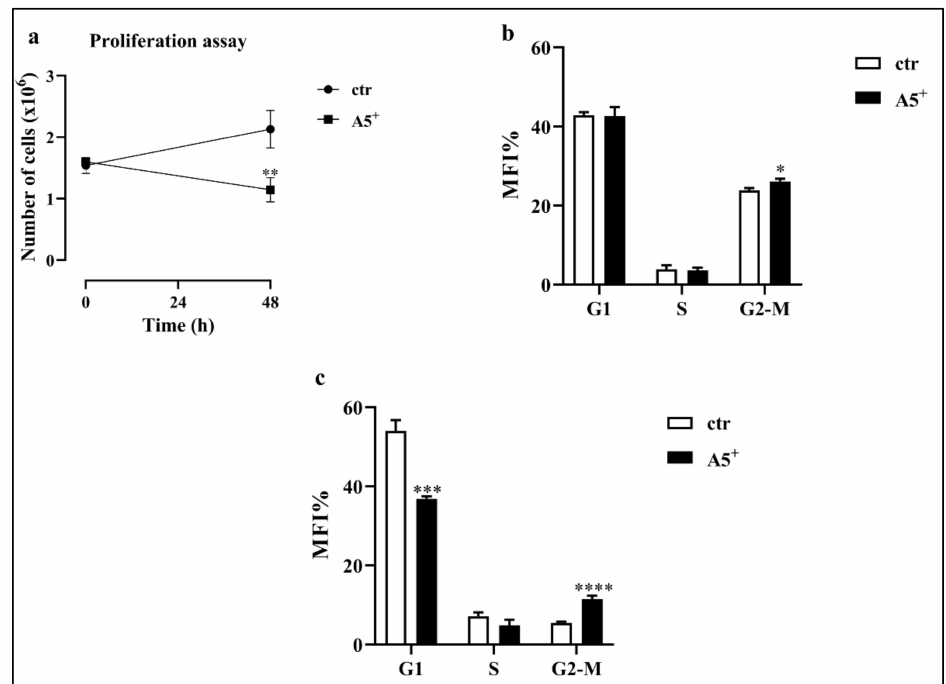
Figure 2. Cell proliferation and cell cycle analysis. ( a ) Cell proliferation during MCE; ( b ) Cell cycle analysis during MCE; ( c ) Cell cycle analysis at day 10. Results are expressed as the mean ± SEM. * p < 0.05, ** p < 0.005, *** p < 0.001, **** p < 0.0001. Graphs illustrate three different experiments conducted